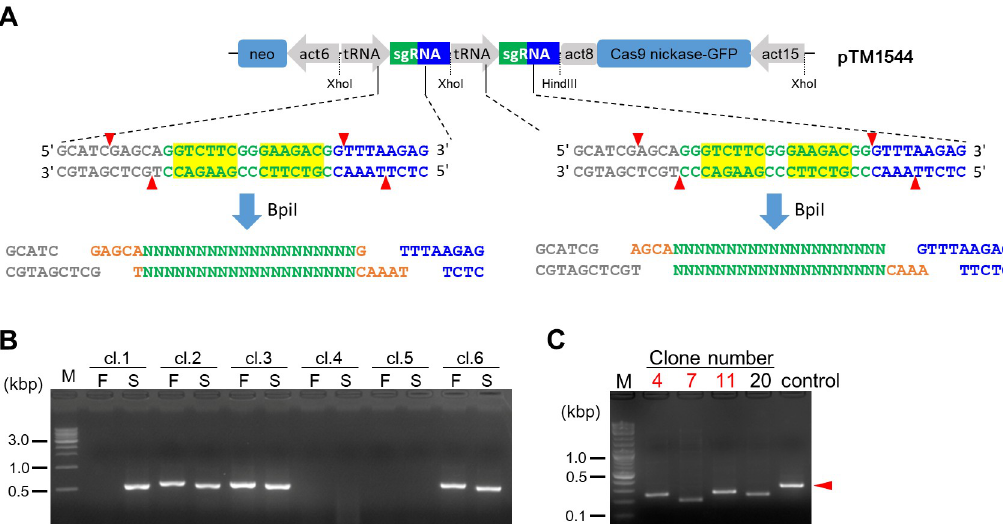
Fig 3. Single-step assembly of a dual sgRNA expression vector and efficient genomic deletion. (A) Schematic of the dual sgRNA expression vector designed for single-step assembly. The yellow highlights indicate the BpiI sites, and the green and orange letters show the target sequences of the sgRNAs and the overhangs for the Golden Gate cloning, respectively. The BpiI sites in both the first and second sgRNA sites generate different overhangs after digestion. act15, act15 promoter; act8, act8 terminator; tRNA, isoleucine tRNA; act6, act6 promoter. (B) Correct insertion of the B1-2 and T1 sgRNA sequences into pTM1544 via one-step cloning. Correct insertion was confirmed via colony PCR. The B1-2 sequence was inserted as the first target (F), and T1 was inserted as the second target (S). (C) Genomic deletions generated via transient introduction of pTM1544. PCR products produced using primers flanking the target sites are shown. The arrowhead indicates product size found in the control (the AX2